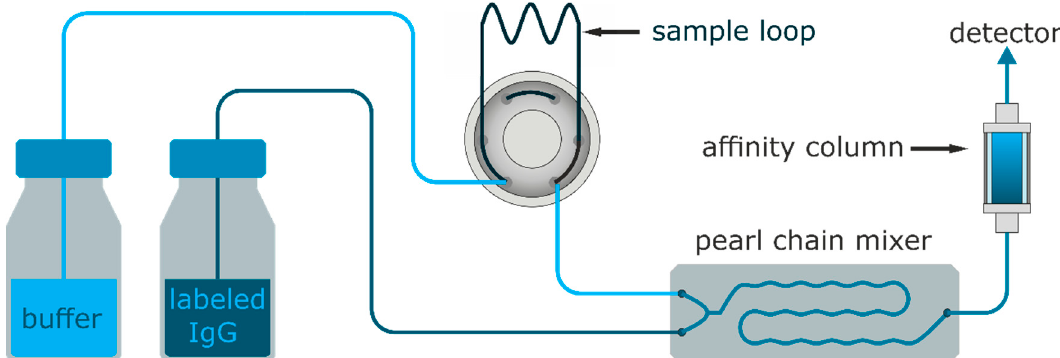
Figure 3. The fluidic setup for the online detection of cocaine. Injections were performed with a six-way-valve on the buffer channel for continuous flow injection. Both channels were mixed 1:1 with a dedicated mixer chip and flown through the BEC-BSA affinity column.